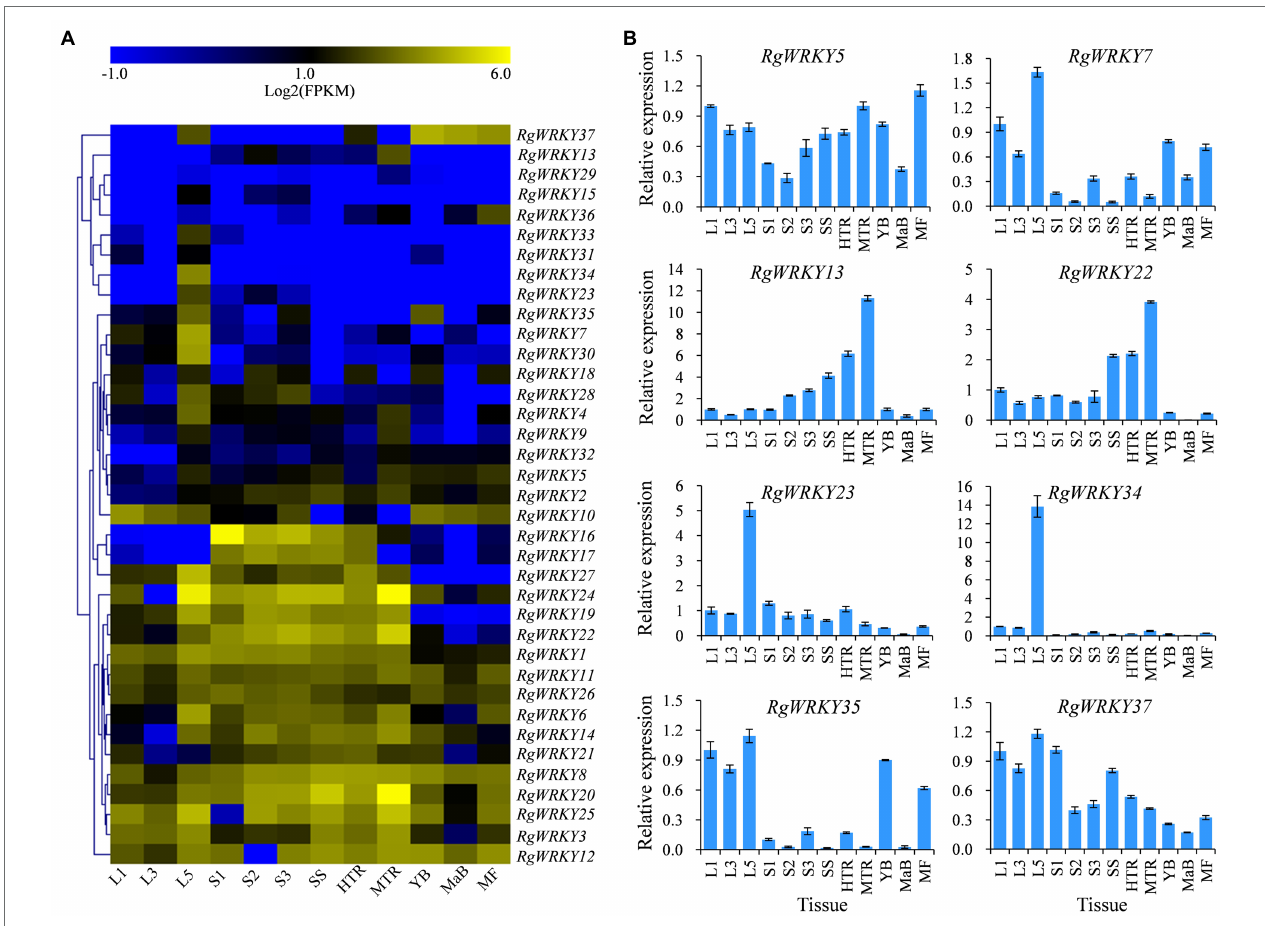
FIGURE 7 | Expression patterns of 37 WRKY genes in various tissues of R. glutinosa . (A) Heat map representing expression dynamics of WRKY genes in different tissues. (B) Relative expression levels of WRKY genes in different tissues by qRT-PCR. L1, tender leaf; L3, fully expanded leaf; L5, old leaf; S1, top of stem; S2, middle piece of stem; S3, lower stem; SS, seed stock; HTR, the head of tuberous root; MTR, the middle of tuberous root; YB, Young flower bud; MaB; mature flower bud; and MF, fully opened